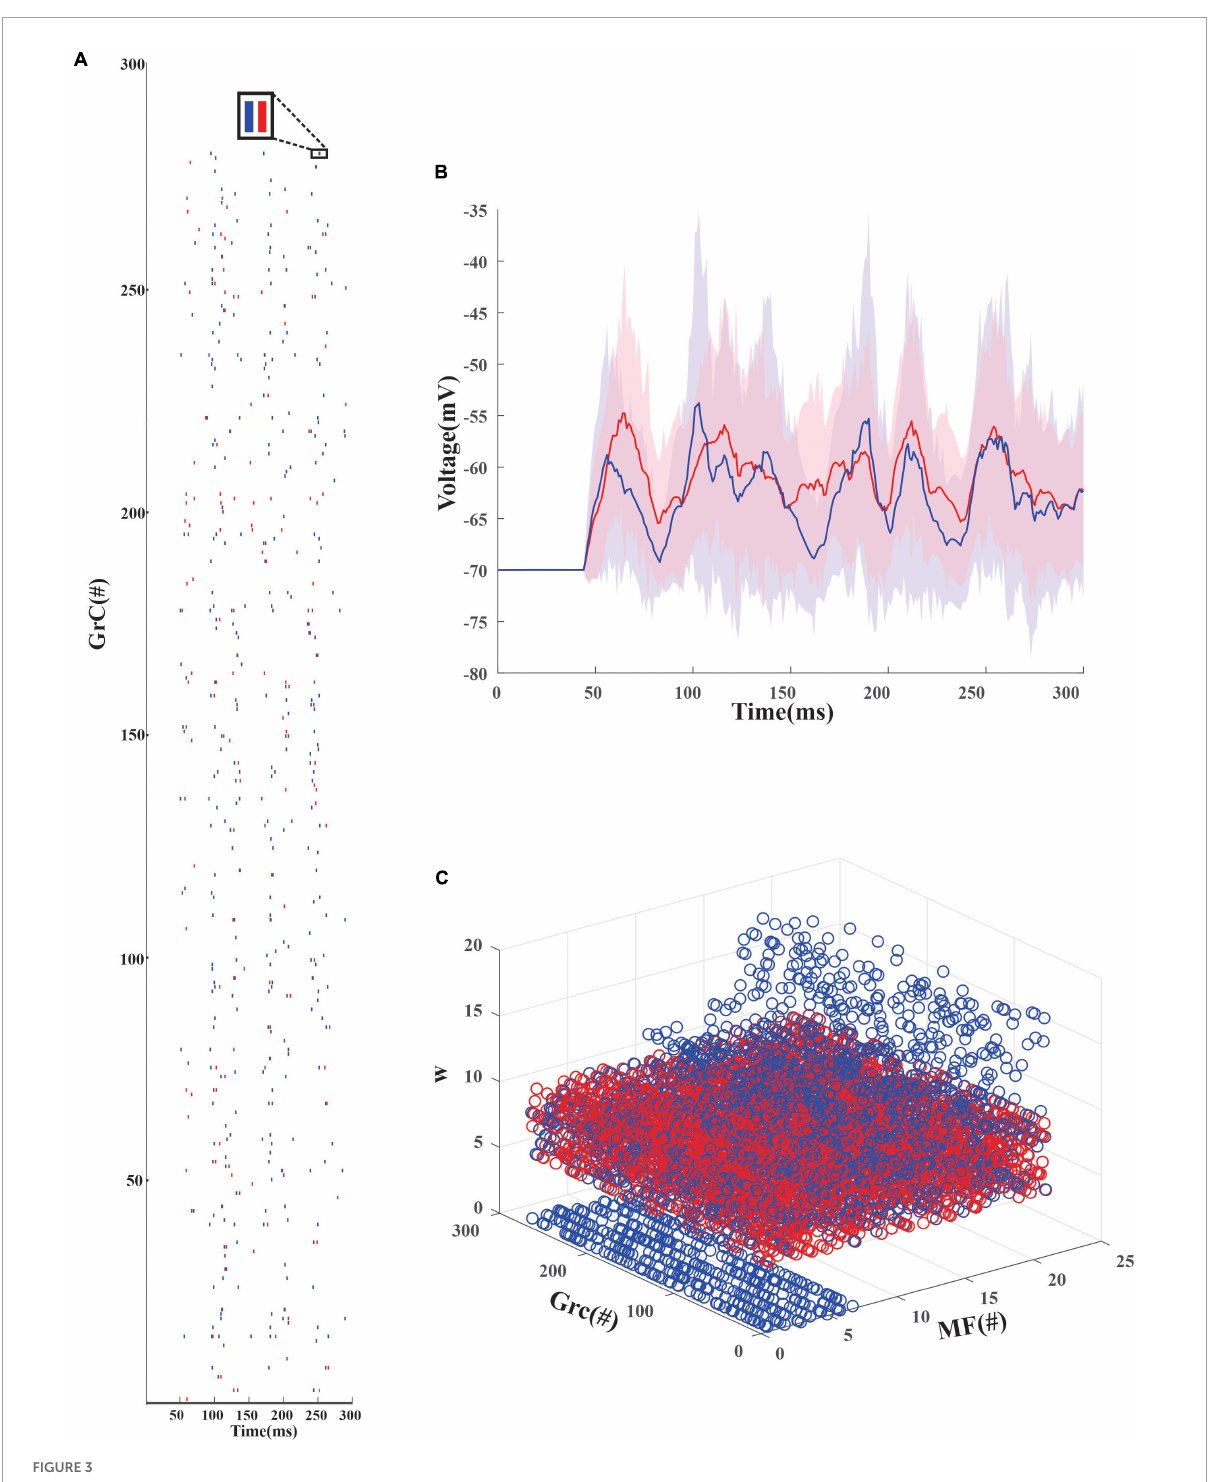
FIGURE3 Firing rate distribution encoded input data in the modeled granule cells in the network. (A) Firing dynamics of GrCs pre and post-learning for 300 ms show the spread of temporal data in the input granular layer resulting from a combination of 4 random MF connections. The red dots represent the spike times of 279 GrC pre-learning and the blue dots represent the updated spike times post-learning. The inset shows the change in the firing dynamics at a particular time point for 1 GrC. Post-learning, some of the granule cells which were firing (e.g., only red raster in GrC1) turn quiescent. (B) Average voltage traces of granule neurons with standard deviation showed minimal change in the firing dynamics before (red) and after (blue) learning (C) . Weights before (red) and after (blue) learning suggest, post learning some GrCs adapt the weights to remain in a state of